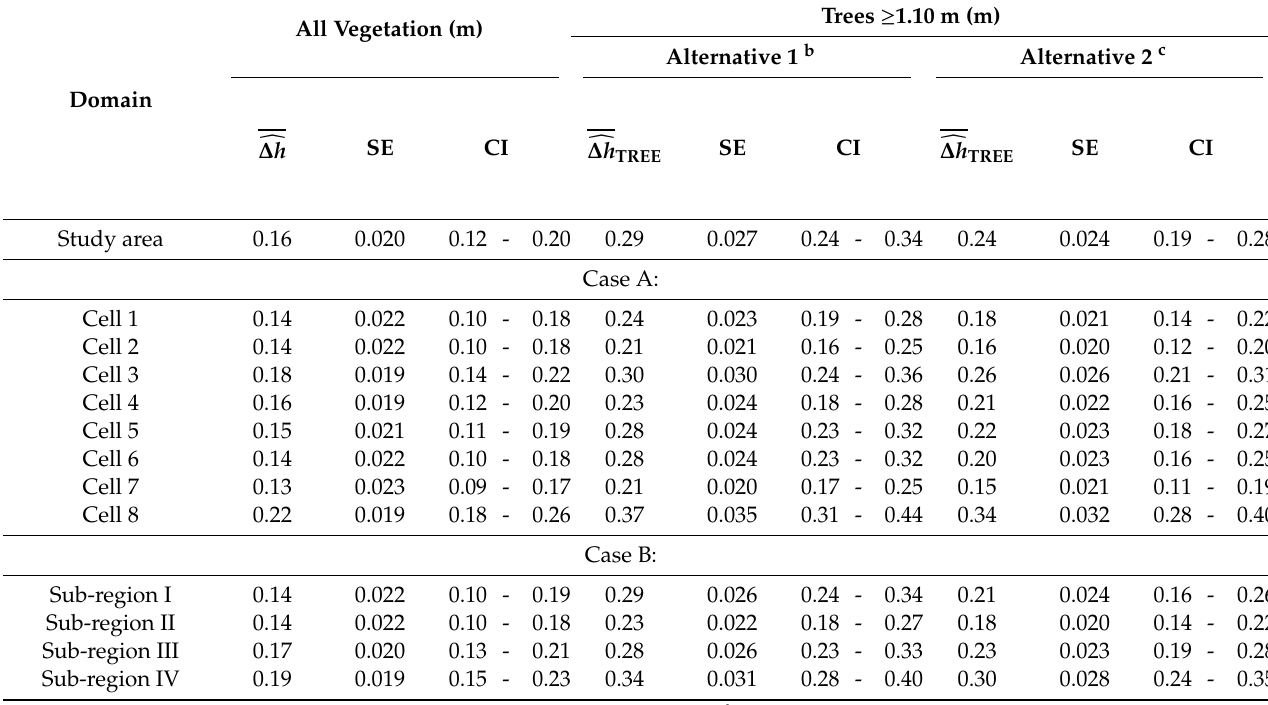
Table 4. Estimates of mean change in vegetation height ( (cid:99) ∆ h ; Equation (4) and in height of trees ≥ 1.10 m ( (cid:99) ∆ h TREE ; Equation (5) for various domains of the study area, and corresponding standard error estimates a (SE) and 95% confidence intervals